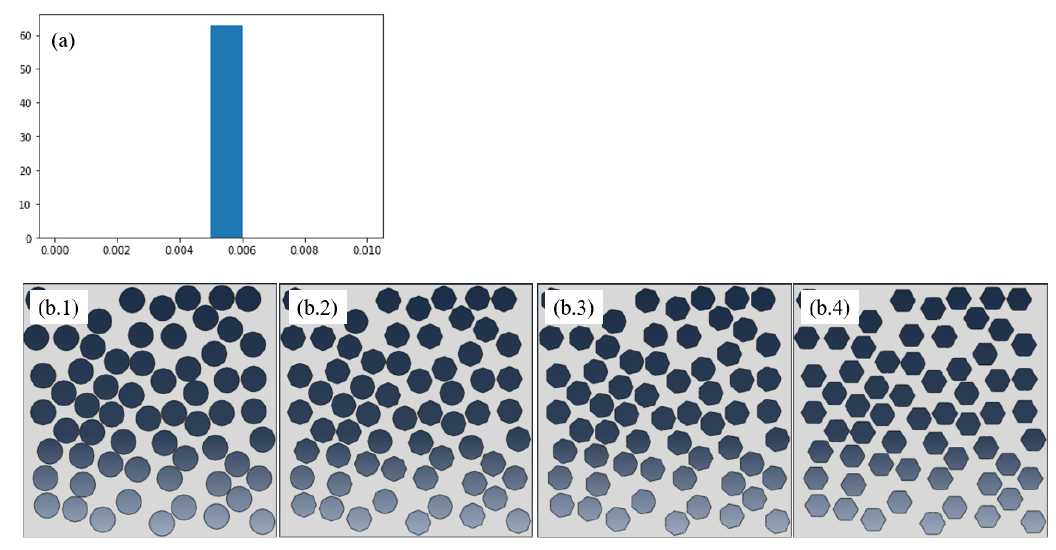
Figure 3. ( a ) Histogram of pores radius; ( b ) Pore shapes: Circle, Octagon, Heptagon and